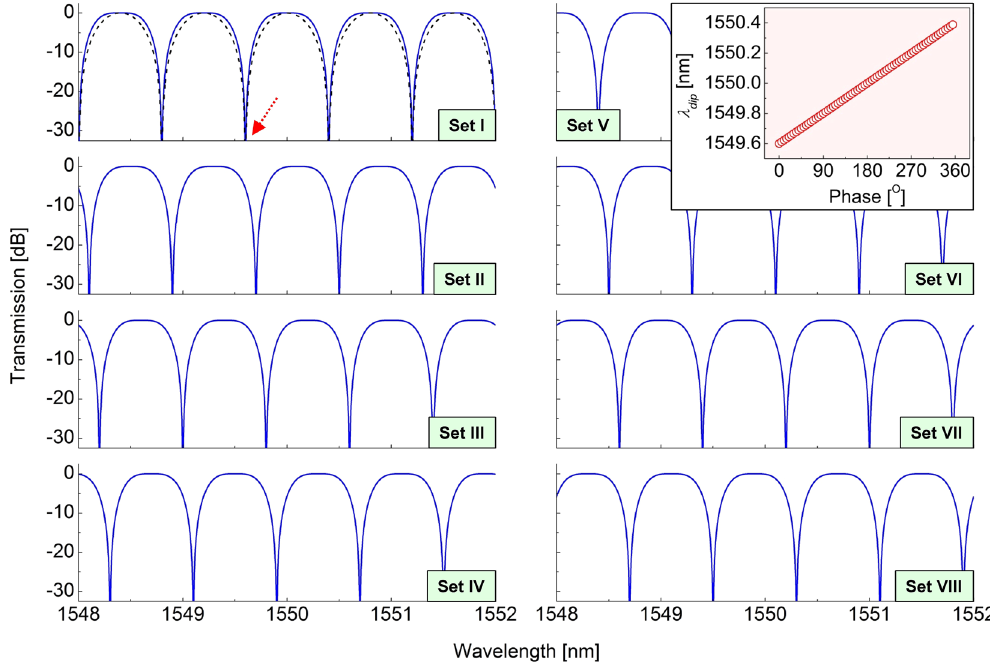
Figure 3. Calculated passband-flattened transmission spectra obtained at eight waveplate angle sets (Sets I– VIII) in Table 1. In this spectra, the length L and birefringence B of each PMF were set as 7.2 m and 4.166 × 10 − 4 to achieve an FSR of ~0.8 nm at 1550 nm, respectively. A black dashed line displays the zeroth-order comb spectrum for comparison. The inset shows the variation of λ dip (indicated by a red arrow at Set I) for waveplate angle sets that provide finer values of φ (step: